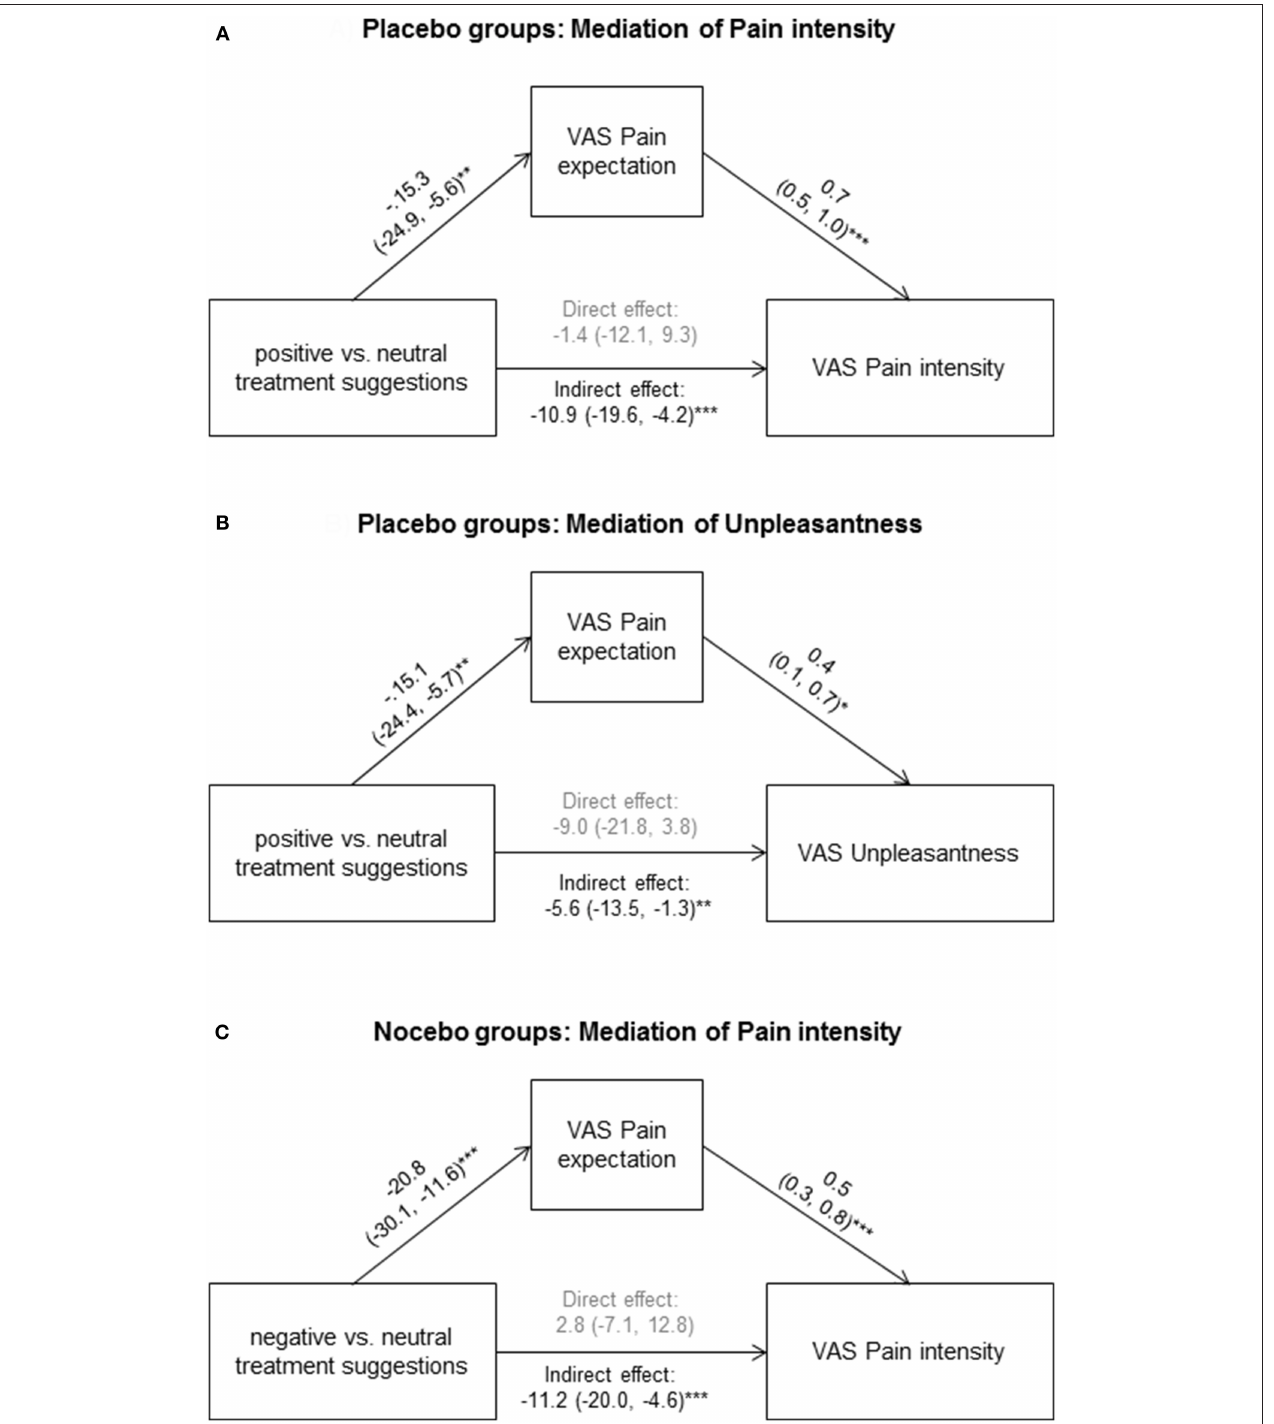
FIGURE 3 | To explore if pain expectation mediated effects of positive treatment suggestions, we conducted mediation analyses on data from placebo and neutral suggestion groups for pain intensity (A) and unpleasantness (B) , as well as on data from nocebo and neutral suggestion groups for pain intensity (C) . Standardized coefficients with 95% CIs are shown. * p < 0.05; ** p < 0.01; *** p < 0.001.